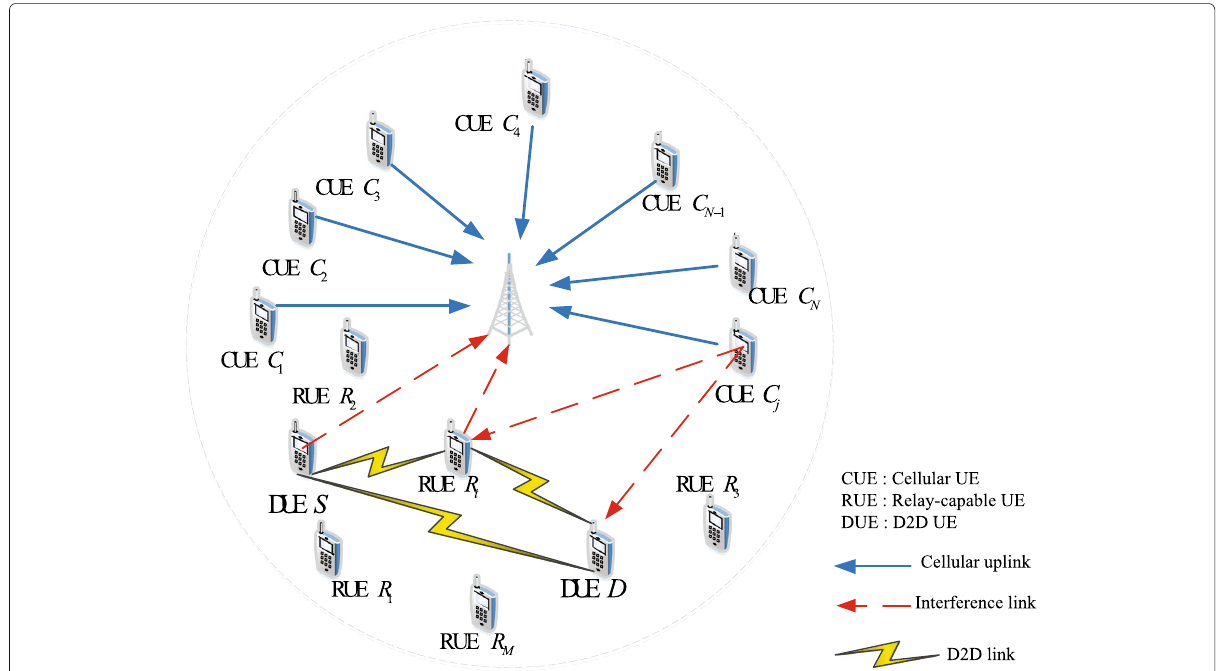
Fig. 1 System model for a single-cell scenario in modern cellular systems